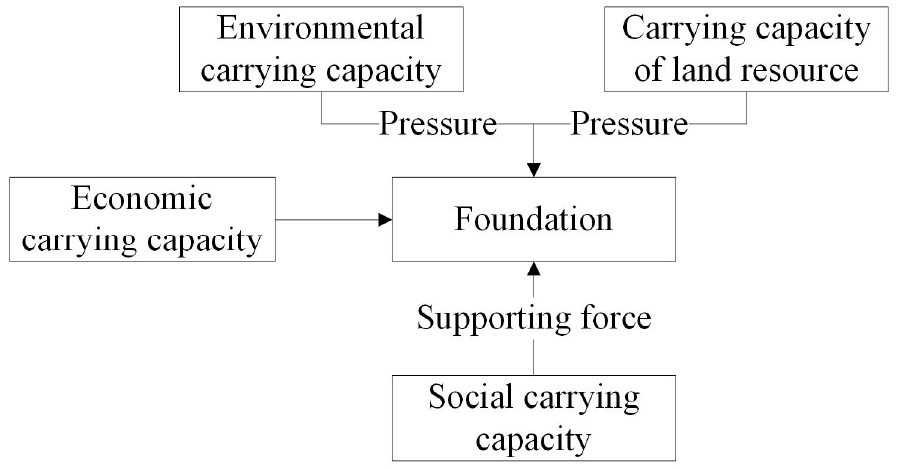
Figure 5. Framework of the coupling model.